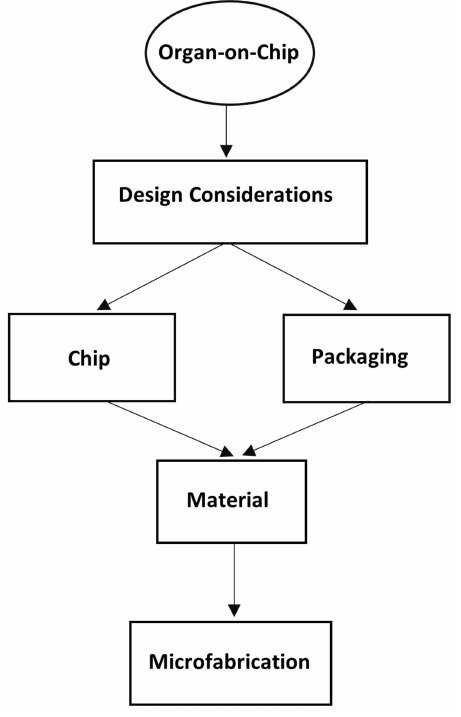
Figure 9. Design and fabrication flowchart of